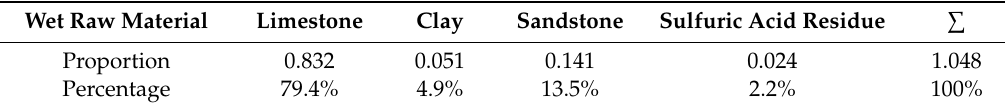
Table 10. Wet raw material ratio.